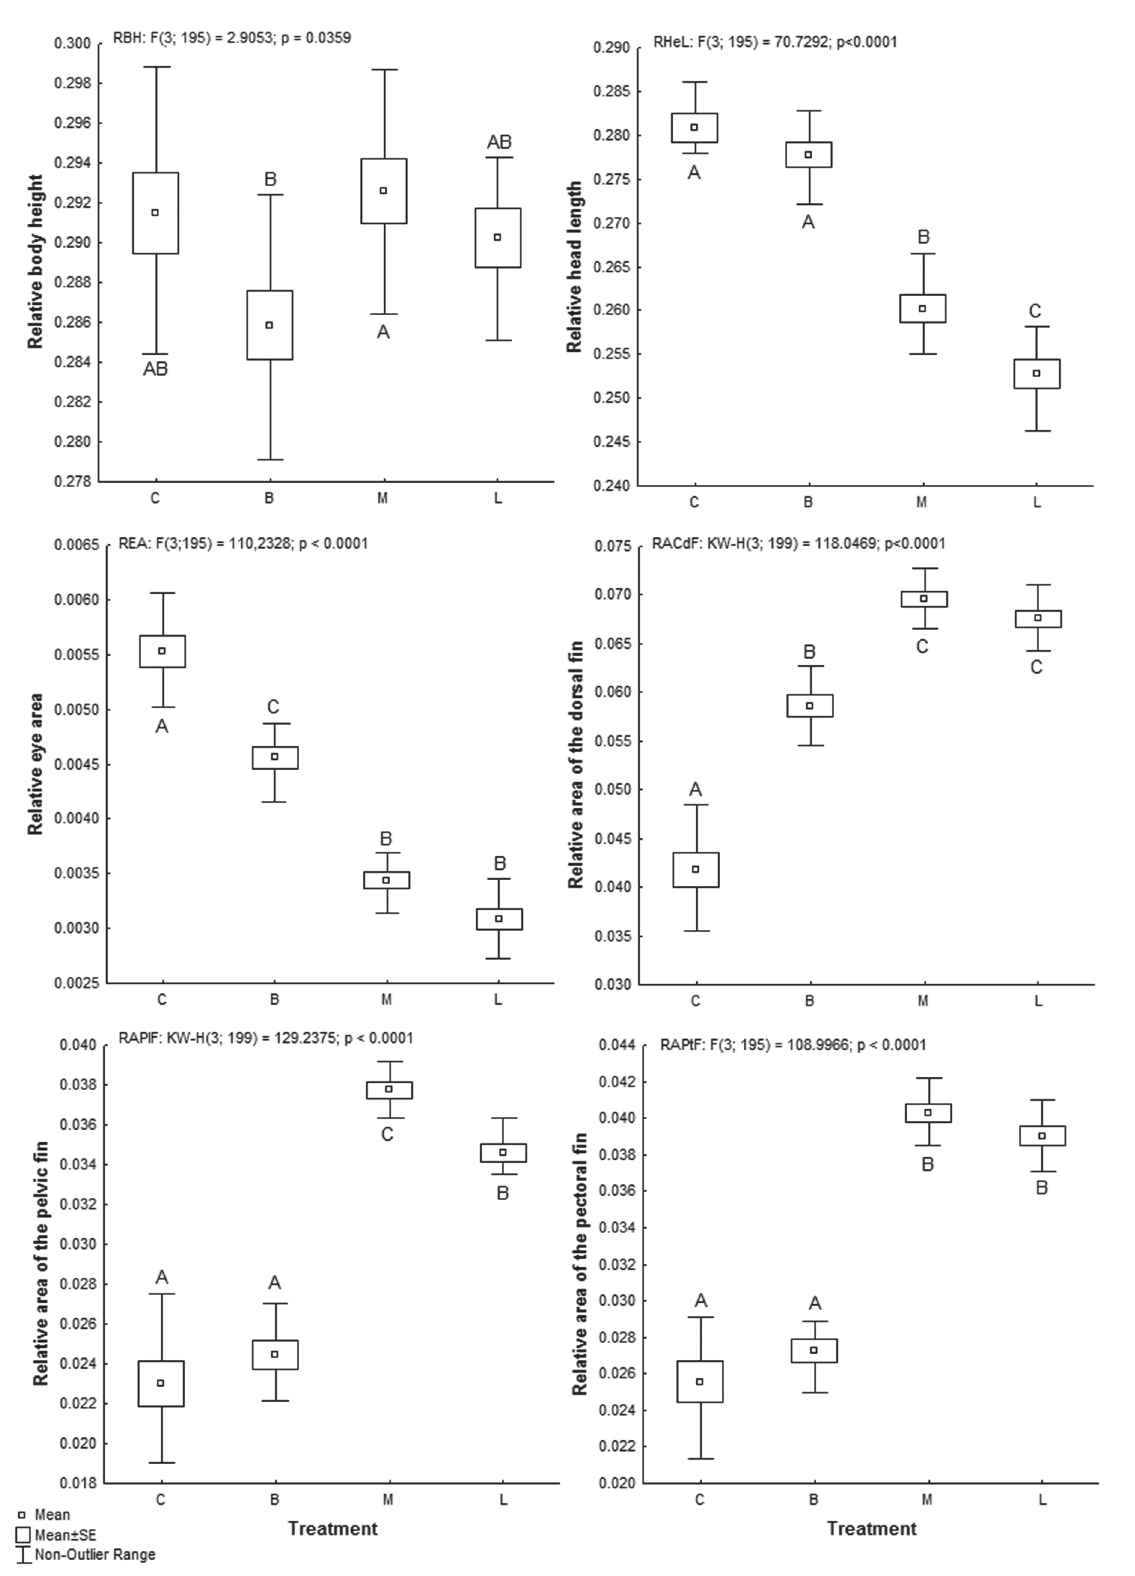
Fig. 6. Most important ecomorphological attributes for Brycon orbignyanus in the morphological differentiation among treatments, according to the ANOVA and the DCA, concomitantly. Treatments with a different letter above their ranges differed